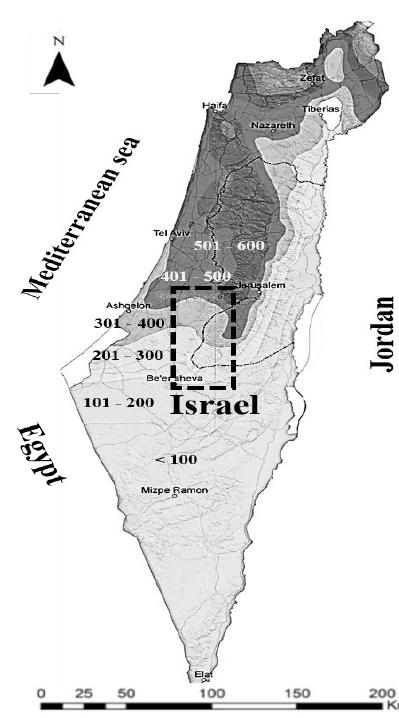
Figure 1 . The study area with field experiments sites is marked with a rectangular box. The contour indicates mean annual precipitations (mm/year).